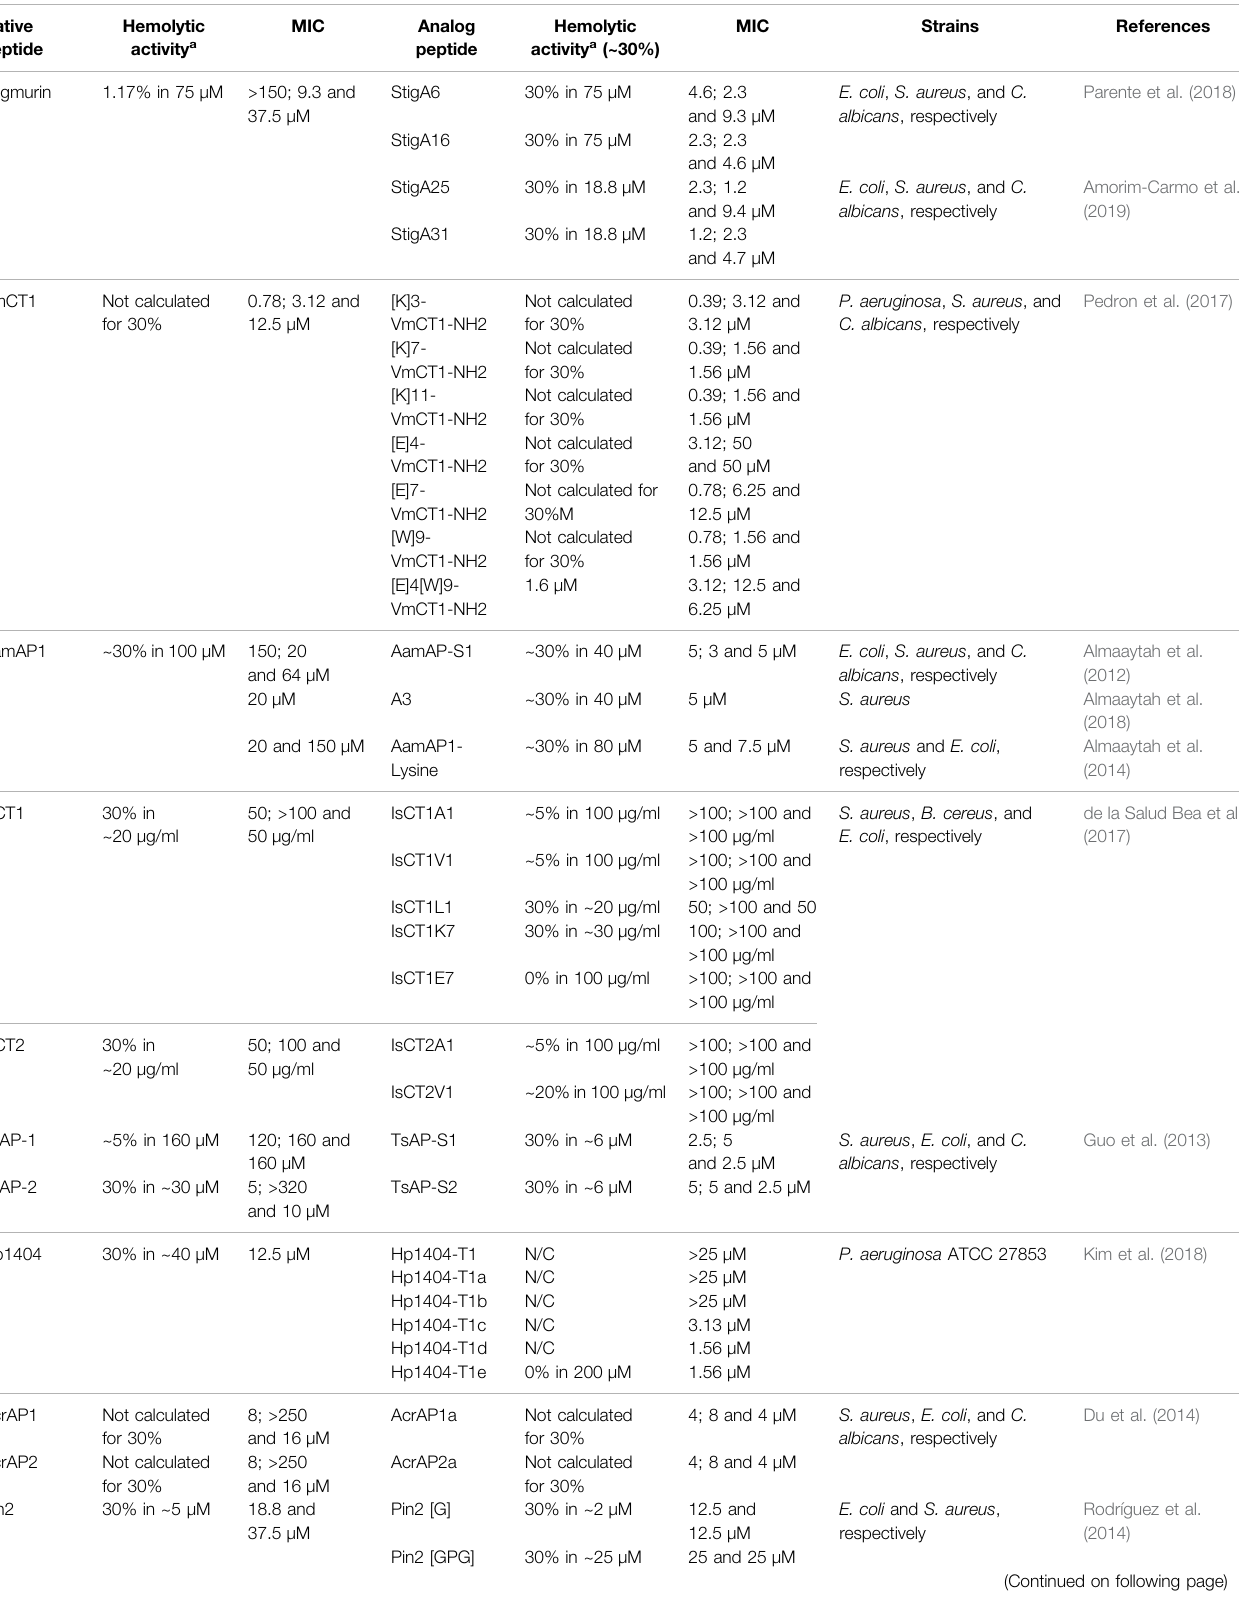
TABLE 2 | Comparison of hemolytic and antimicrobial activities of native scorpion peptides and their analogs after modi fi cations. Native